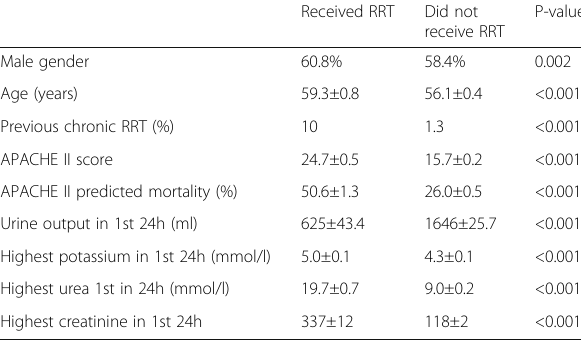
Table 39 (abstract A103). Demographics and